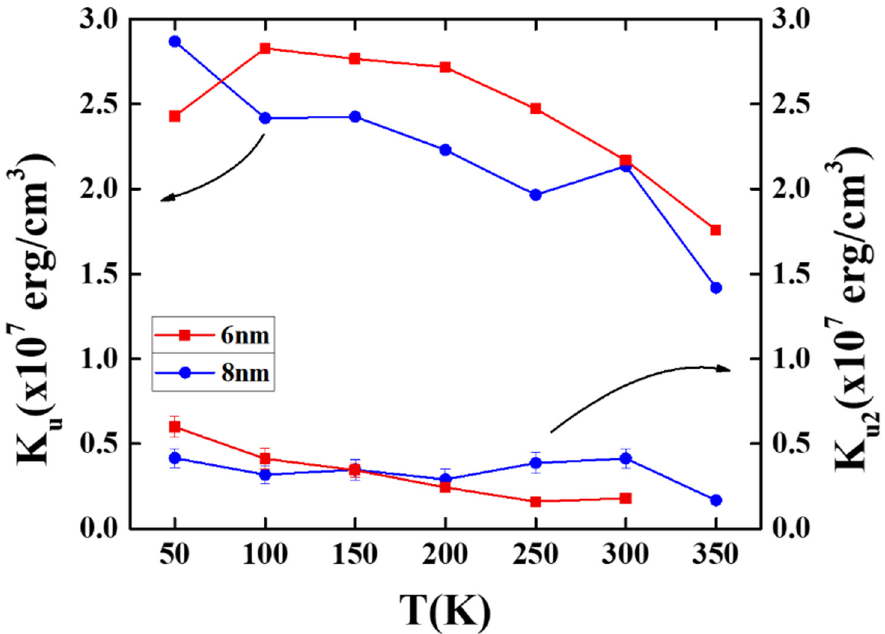
Figure 5. Temperature dependence of the magnetic anisotropy constants (K u ) and the forth-order anisotropy constant (K u2 ) of FePt (B, Ag, C)/MoC/MgTiON/CrRu films. The L1 0 FePt-(B, Ag, C) films with thicknesses of 6 nm and 8 nm showed maximum K u values of 2.83 × 10 7 erg/cm 3 at 100 K and 2.87 × 10 7 erg/cm 3 at 50 K, respectively, and